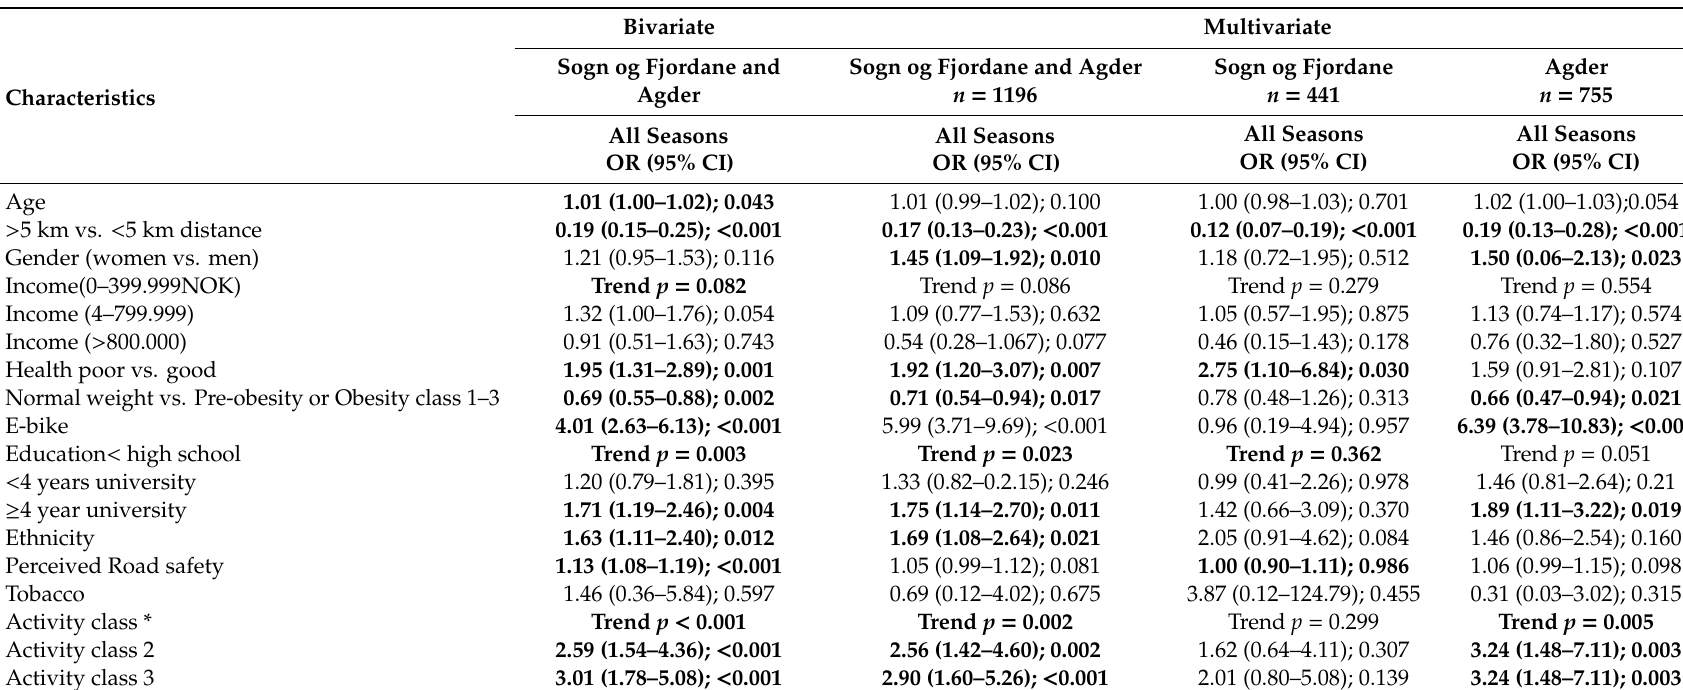
Table A1. Likelihood of being a cyclist, survey data, n = 1196. Presented as bivariate and multivariate analyses. Significant associations are written in